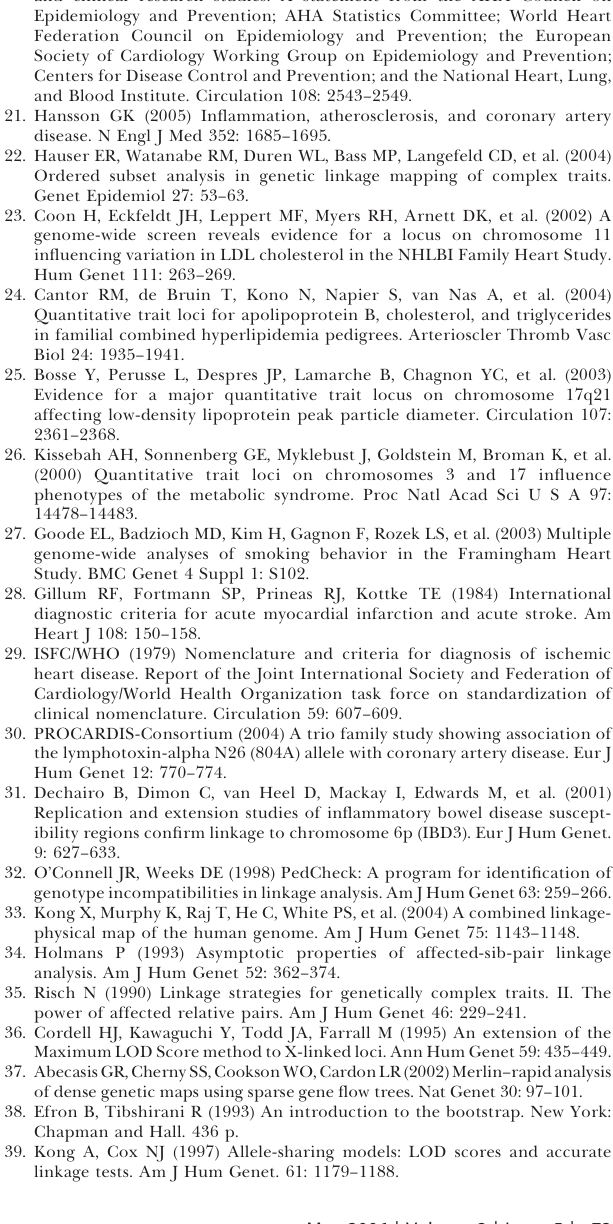
Figure S1. A Genome-Wide Scan of CAD and MI